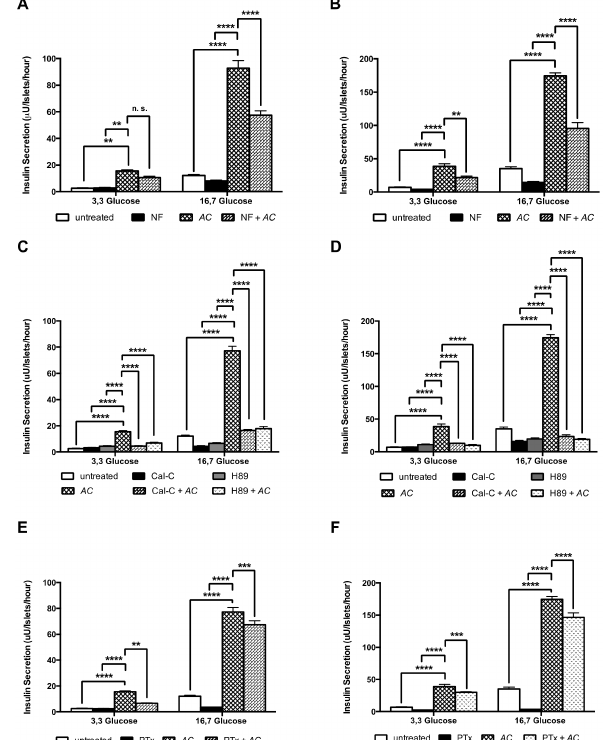
Figure 8. AC stimulates insulin secretion through PKC and PKA systems, L-type calcium channels and G protein-coupled exocytosis. The insulin secretion was evaluated in islets cultured at low (3.3 mM) and high (16.7 mM) glucose in presence of AC (20 mg/mL), and the different inhibitors. 10 µ M NF in GK ( A ) and W rats islets ( B ); 1.5 µ M Cal-C or 10 µ M H89 in GK ( C ) and W rats islets ( D ); and 100 ng/mL PTx in GK ( E ) and W rats islets ( F ). Insulin concentration was measured by radioimmunoassay (RIA). Data are presented as means ± SEM ( n = 8). ** p < 0.01, *** p < 0.001, **** p < 0.0001 when compared to islets treated with AC